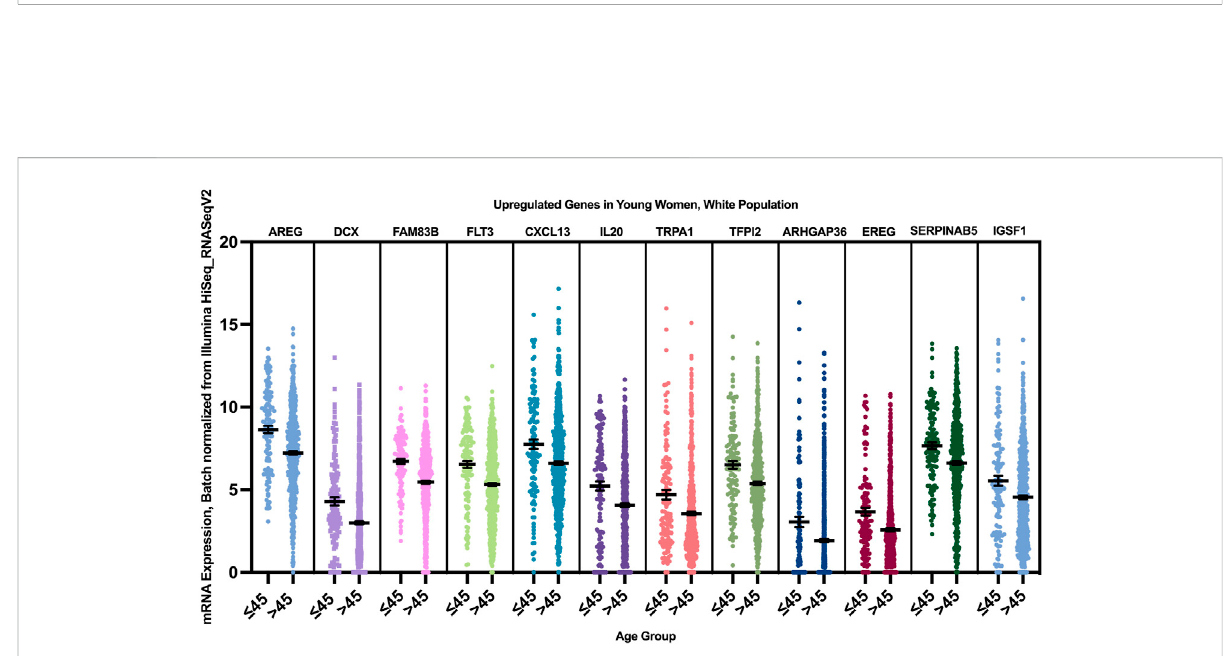
FIGURE 9 Differentially expressed genesin young vs. older patients ofthewhite population ( p < 0.005, student ’ s t-test).Error barsrepresent Mean ±